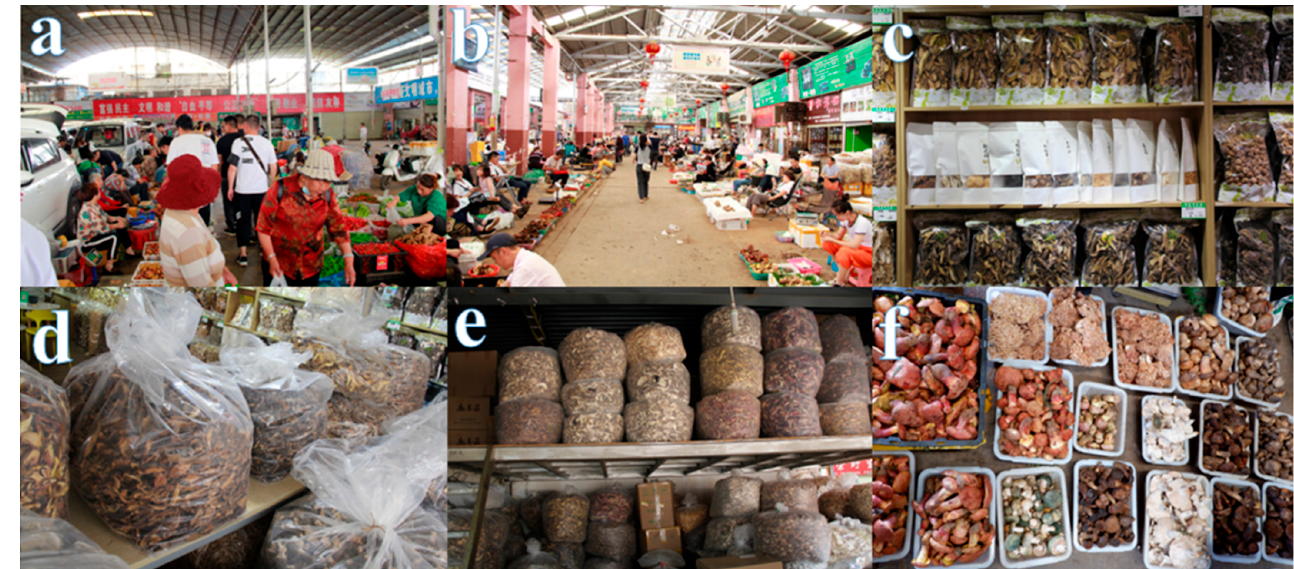
Figure 1. Scenes from a wild mushroom market in Mushuihua, Kunming, Yunnan Province, China ( a , b ). ( c ) Display of edible mushrooms in a dry retail shop. ( d , e ) Display of goods in a dry wholesale shop. ( f ) Display of some species of edible mushrooms.